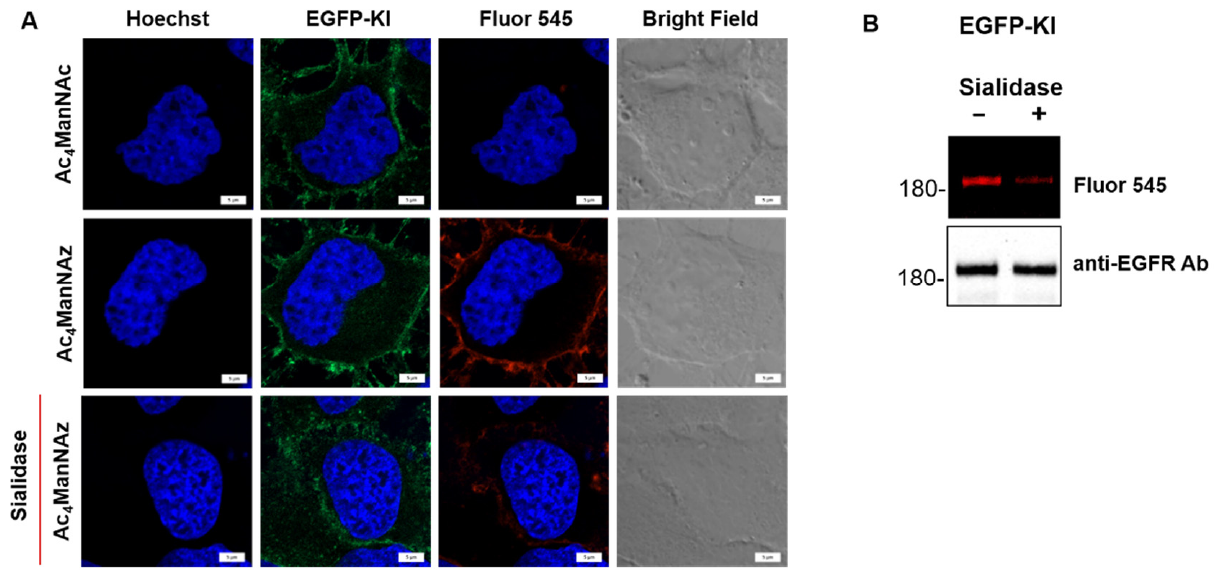
Figure 4. Confirmation of EGFR-GFP desialylation by sialidase in EGFP-KI cells using SPAAC. ( A ) Fluorescence images of azido sialic acids (SiaNAz) labeling with Fluor 545 through SPAAC in EGFP-KI cells (pretreated with Ac 4 ManNAz for 3 days) and the effect of sialidase (3 U/mL) on the labeling. Scale bar, 5 µ m; ( B ) In-gel fluorescence analysis of Fluor 545-labeled EGFR-GFP immunoprecipitation-enriched EGFP-KI cell lysates with and without prior sialidase